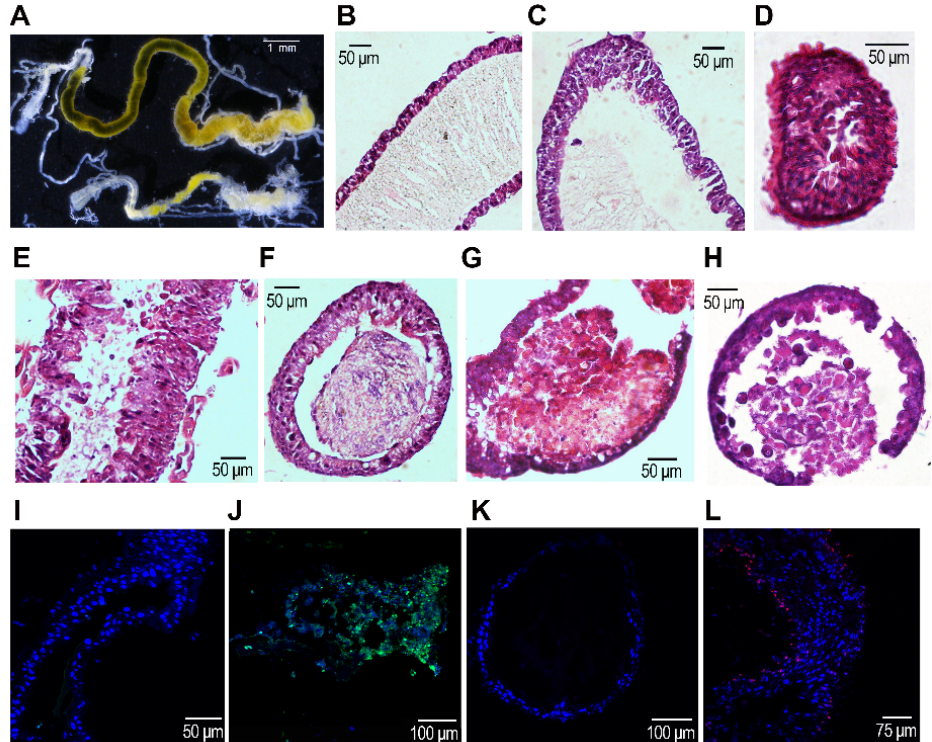
Figure 3. Feeding ds vATPaseG affects the structure of midguts in Henosepilachna vigintioctopunctata . The newly-ecdysed fourth instar larvae had ingested PBS-, ds egfp -, and ds vATPaseG -dipped leaves for three days. The guts were dissected 4 days after the initiation of bioassay ( A ). The midgut sections from ds egfp - ( B – D ) and ds vATPaseG -fed ( E – H ) larvae were stained with hematoxylin-eosin (HE) method. The midguts from PBS- and ds egfp -fed larvae have tall and columnar epithelium cells (EP) and clear peritrophic membrane (PM), in contrast to ds vATPaseG -fed larvae. Midgut sections from fourth-instar larvae were stained with DAPI and Hoechst 33342 and to visualize the DNA, and TUNEL kit and 5-ethynyl-2 ′ -deoxyuridine (EdU) Alexa FluorTM 594 to see the apoptotic and actively dividing cells respectively. Merged images of DAPI/TUNEL ( I , J ) and Hoechst 33342/EdU staining are shown ( K , L ). The TUNEL- and EdU-positive cells in the midgut of ds vATPaseG -fed larvae are green and red in color respectively ( J , L ), in contrast to DAPI-positive cells (blue) in the midgut of ds egfp -fed larvae ( I , K ).